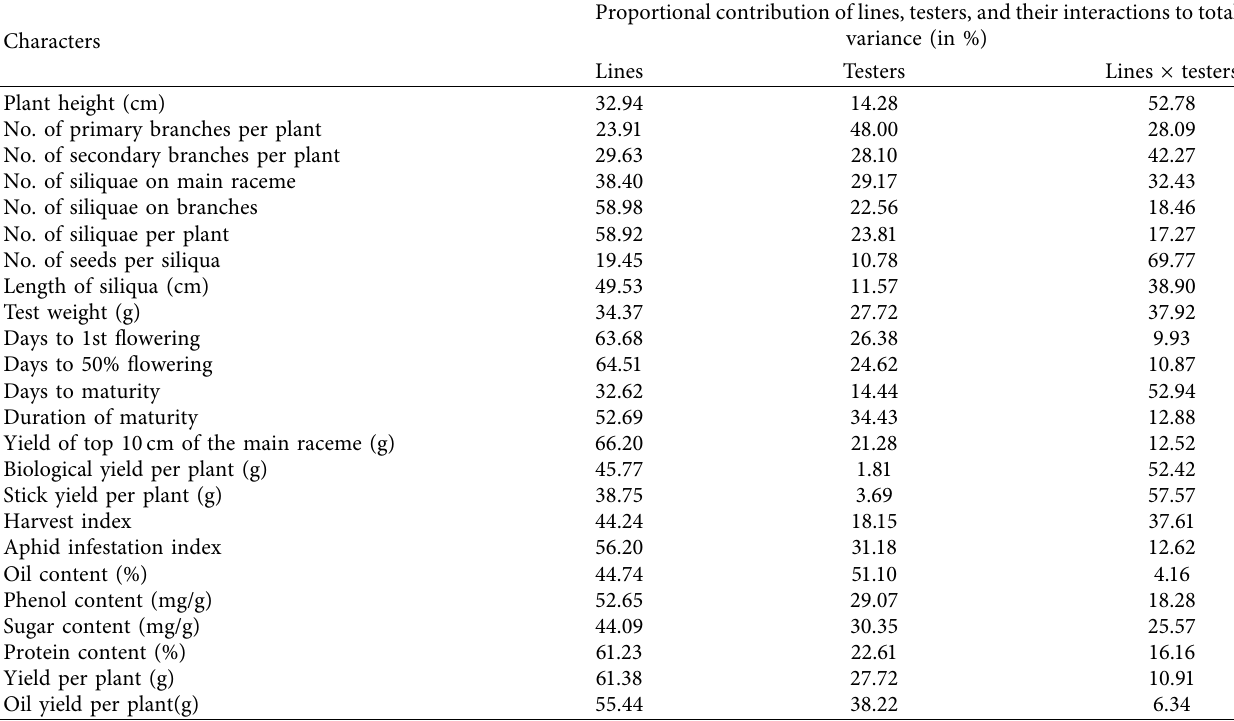
Table 15: Proportional contribution of lines, testers, and their interactions to total